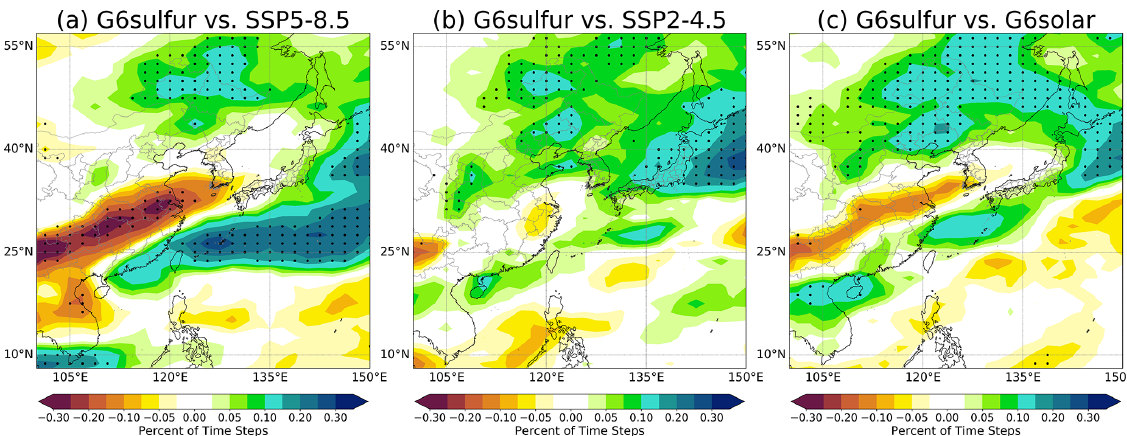
Figure 8. Differences in annual mean AR frequency for the future period of 2071–2100 between G6sulfur and SSP5–8.5 (a) and SSP2– 4.5 (b) and G6solar (c) . Stippling indicates differences that are statistically significant at a confidence level of > 95% ( p value < 0.05 based on Student’s t